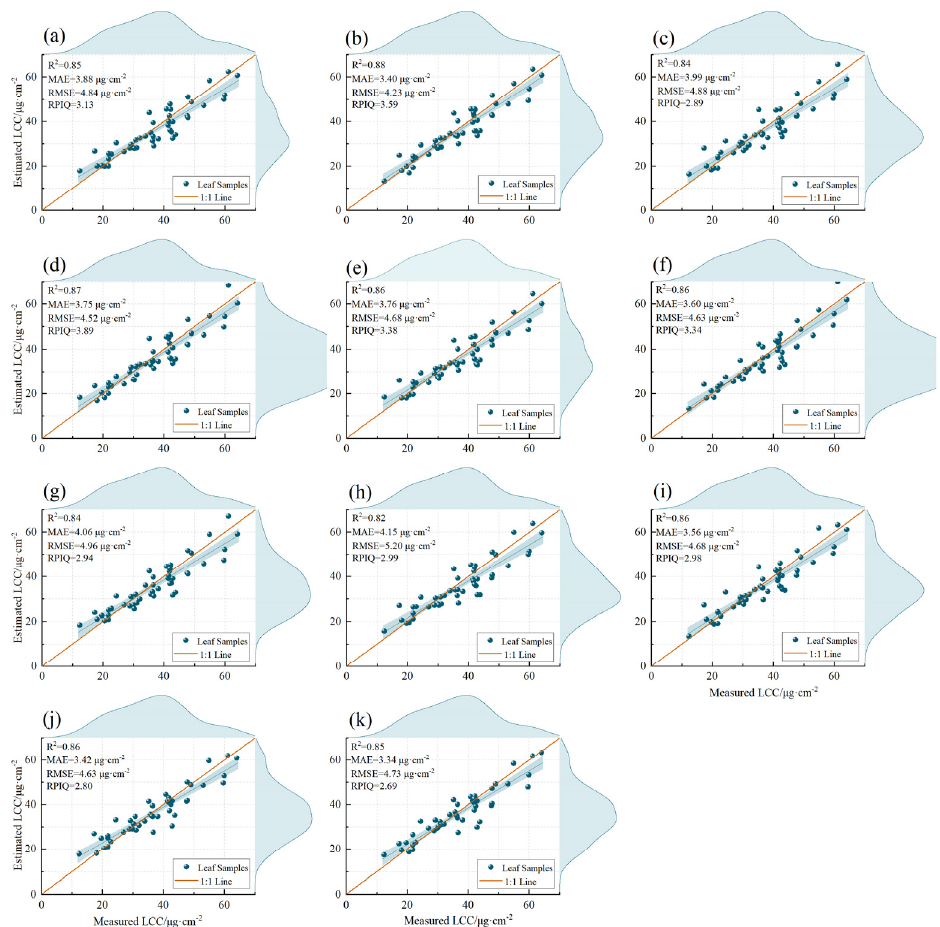
Figure 3. Scatterplots with the marginal histograms of measured and estimated LCCs based on the best MLRA at the 0–2 order. ( a ): 0-GPR; ( b ): 0.2-RR; ( c ): 0.4-GPR; ( d ): 0.6-GPR; ( e ): 0.8-RR; ( f ): 1-RR; ( g ): 1.2-SVR; ( h ): 1.4-RR; ( i ): 1.6-RR; ( j ): 1.8-RF; ( k ): 2-XGBoost.